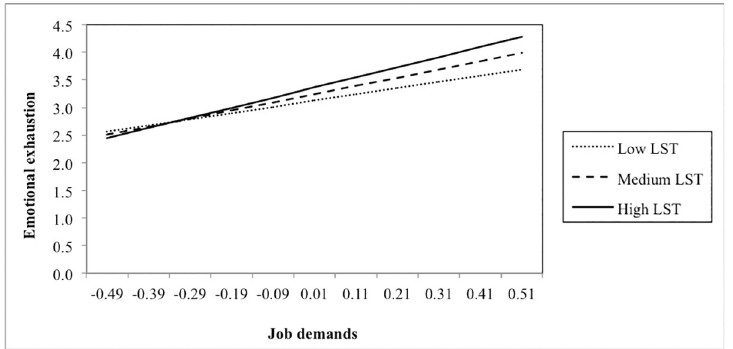
Fig 3. Interaction between job demands and low sensory threshold (LST) in predicting emotional exhaustion.